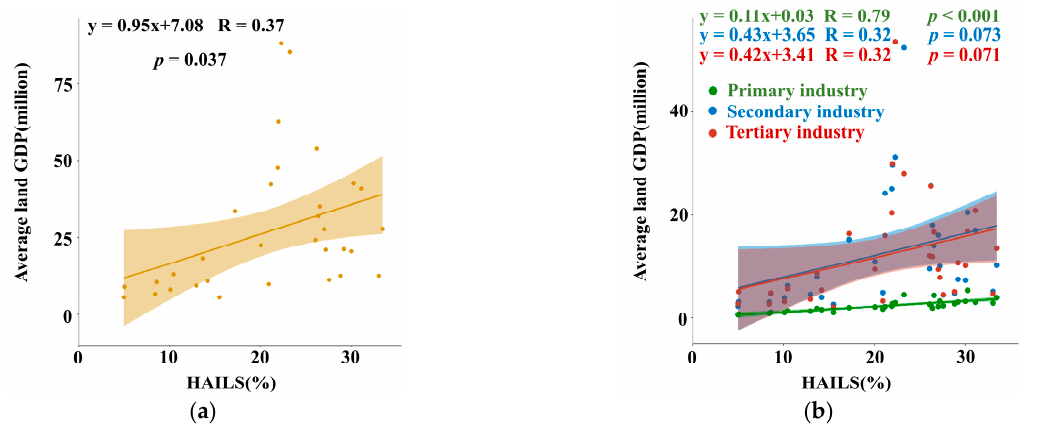
Figure 6. Correlation between average land GDP and the HAILS: ( a ) average land GDP; ( b ) average land GDP of primary industry, secondary industry, and tertiary industry.